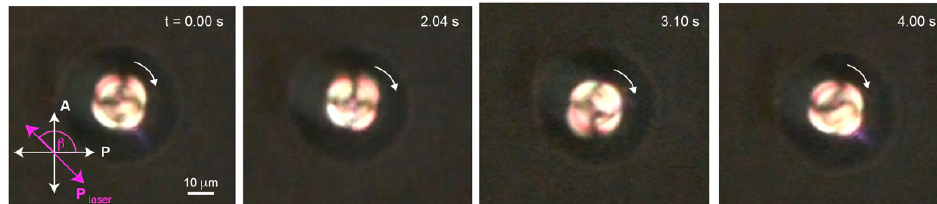
Figure 3. An NLC droplet under linearly polarized laser trap was found rotating clockwise at laser power 298 mW. The laser polarization direction was set at an angle β = 135° with respect to the horizontal (Supplementary video available).